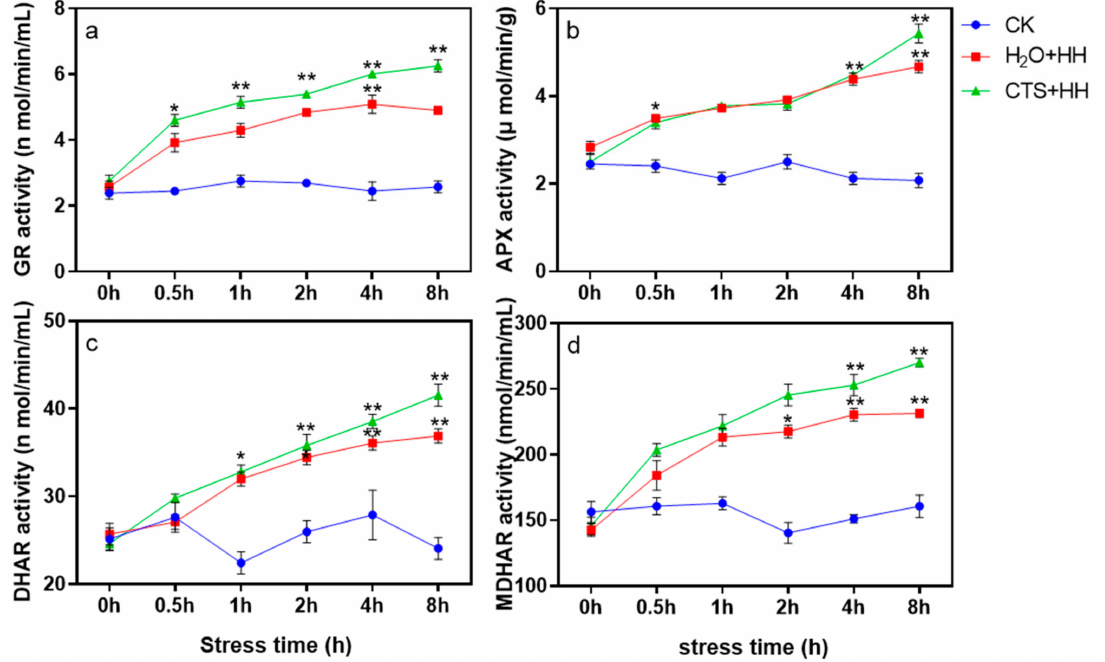
Figure 8. Effects of CTS on the activities of key enzymes of the AsA-GSH cycle of strawberry seedlings under high-temperature and high-light stress. ( a ) activities of glutathione reductase, GR; ( b ) activities of ascorbate peroxidase, APX; ( c ) activities of dechlorascorbate reductase, DHAR; ( d ) activities of monodehydroascorbate reductase, MDHAR. CK: H 2 O + 23 ◦ C + 400 µ mol · m − 2 · s − 1 ; H 2 O + HH: H 2 O + 38 ◦ C + 1800 µ mol · m − 2 · s − 1 ; CTS + HH: CTS + 38 ◦ C + 1800 µ mol · m − 2 · s − 1 . * indicates a significant difference between the treatments (Duncan’s multiple range test; p < 0.05); and **, a very significant difference (Duncan’s multiple range test; p <